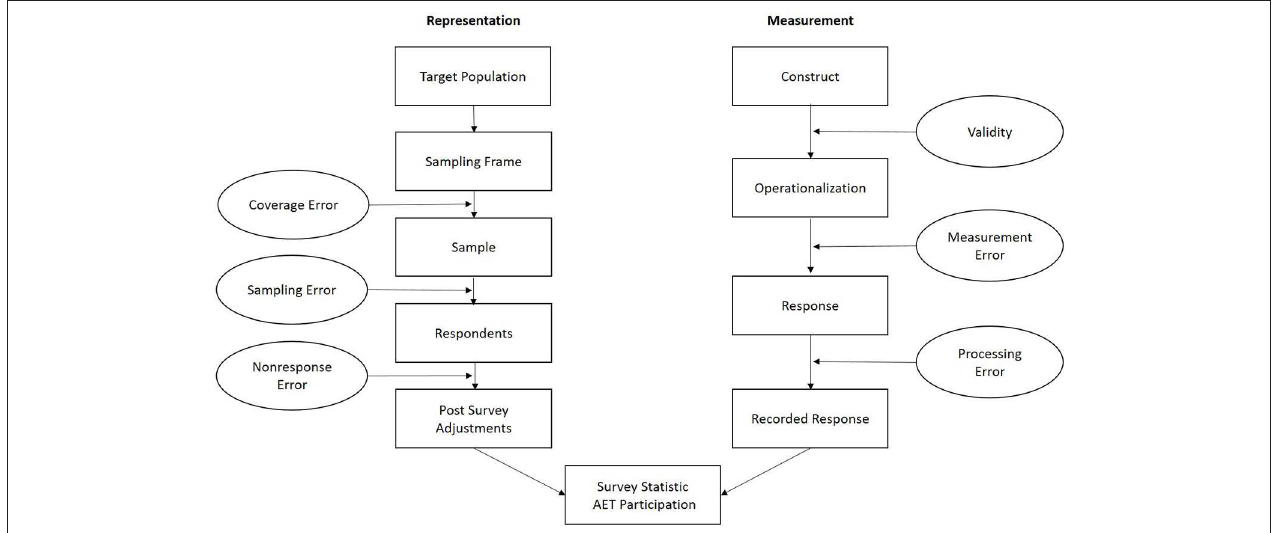
FIGURE 1 | AET surveys from a quality perspective, following Groves et al. (2009) (Figure 2.2, p. 42 and Figure 2.5, p.